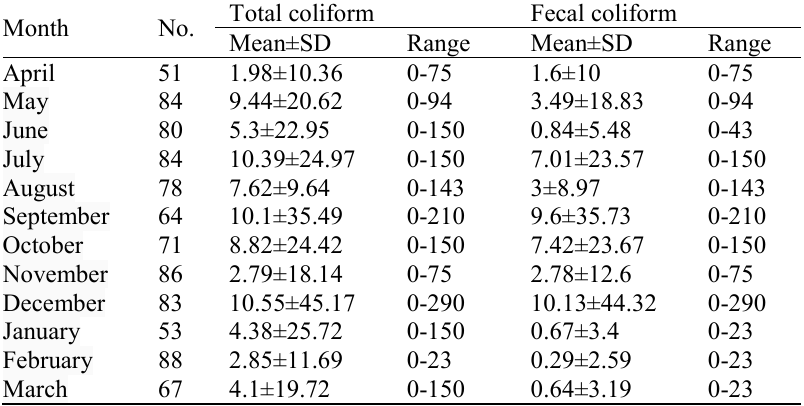
Table 4. Microbial parameters of water distribution networks in Dasht-e Azadegan County,